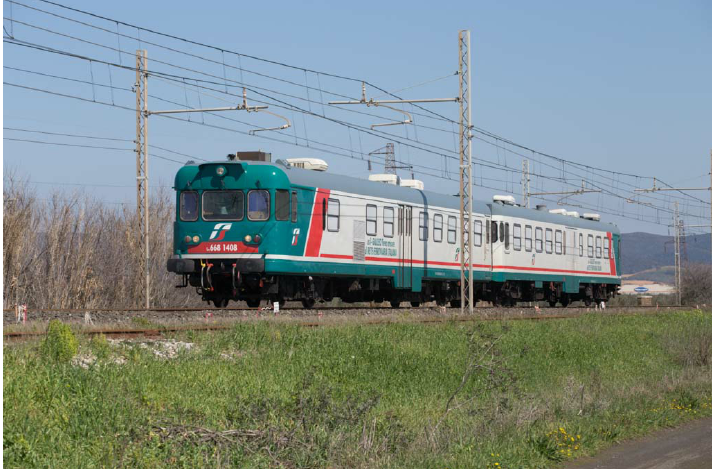
Figure 9. Ultrasonic testing vehicle “us1-Galileo” (courtesy of c (cid:13) Benedetto